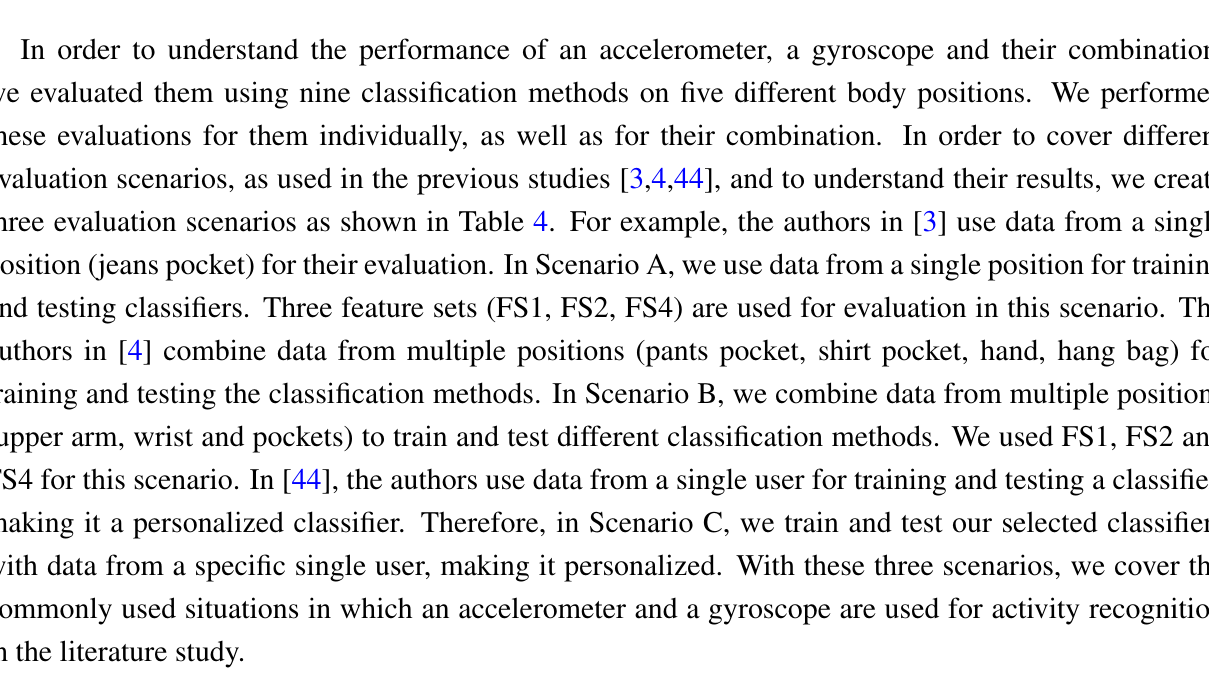
Table 4. Evaluation scenarios for the accelerometer and the